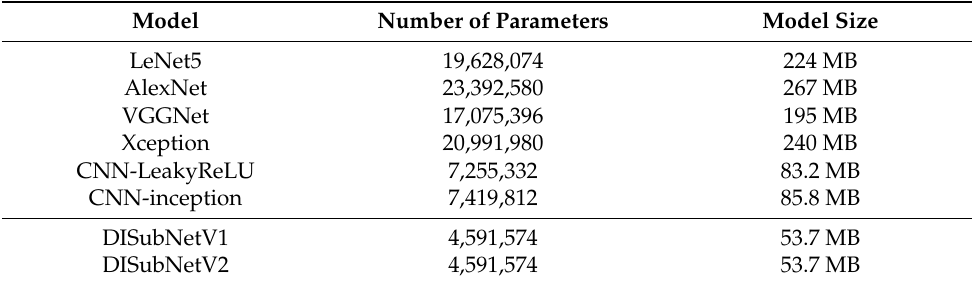
Table 3. Model parameters and size